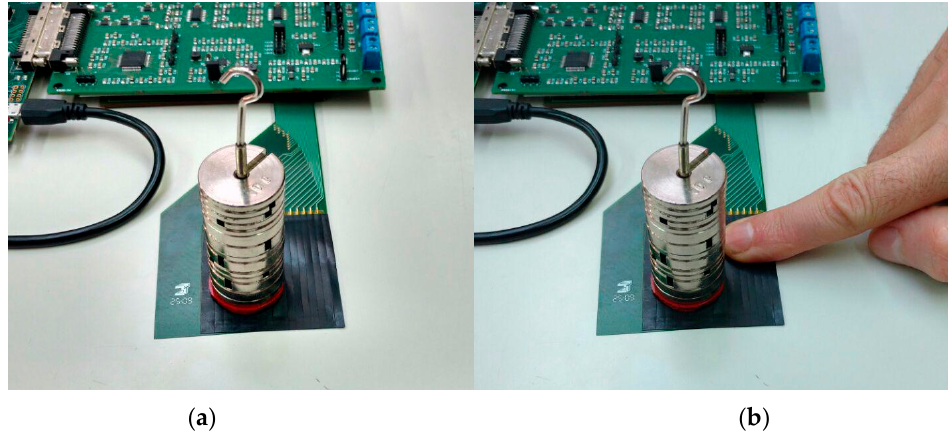
Figure 10. ( a ) Tactile sensor pressed with a weight of 200 g; ( b ) Tactile sensor pressed in two different areas with a weight of 200 g and a finger.